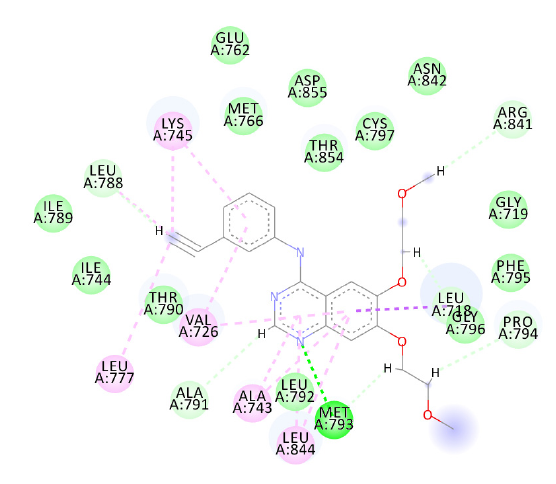
Val726-Leu777, and Leu777-Leu788, respectively (Figure 8).